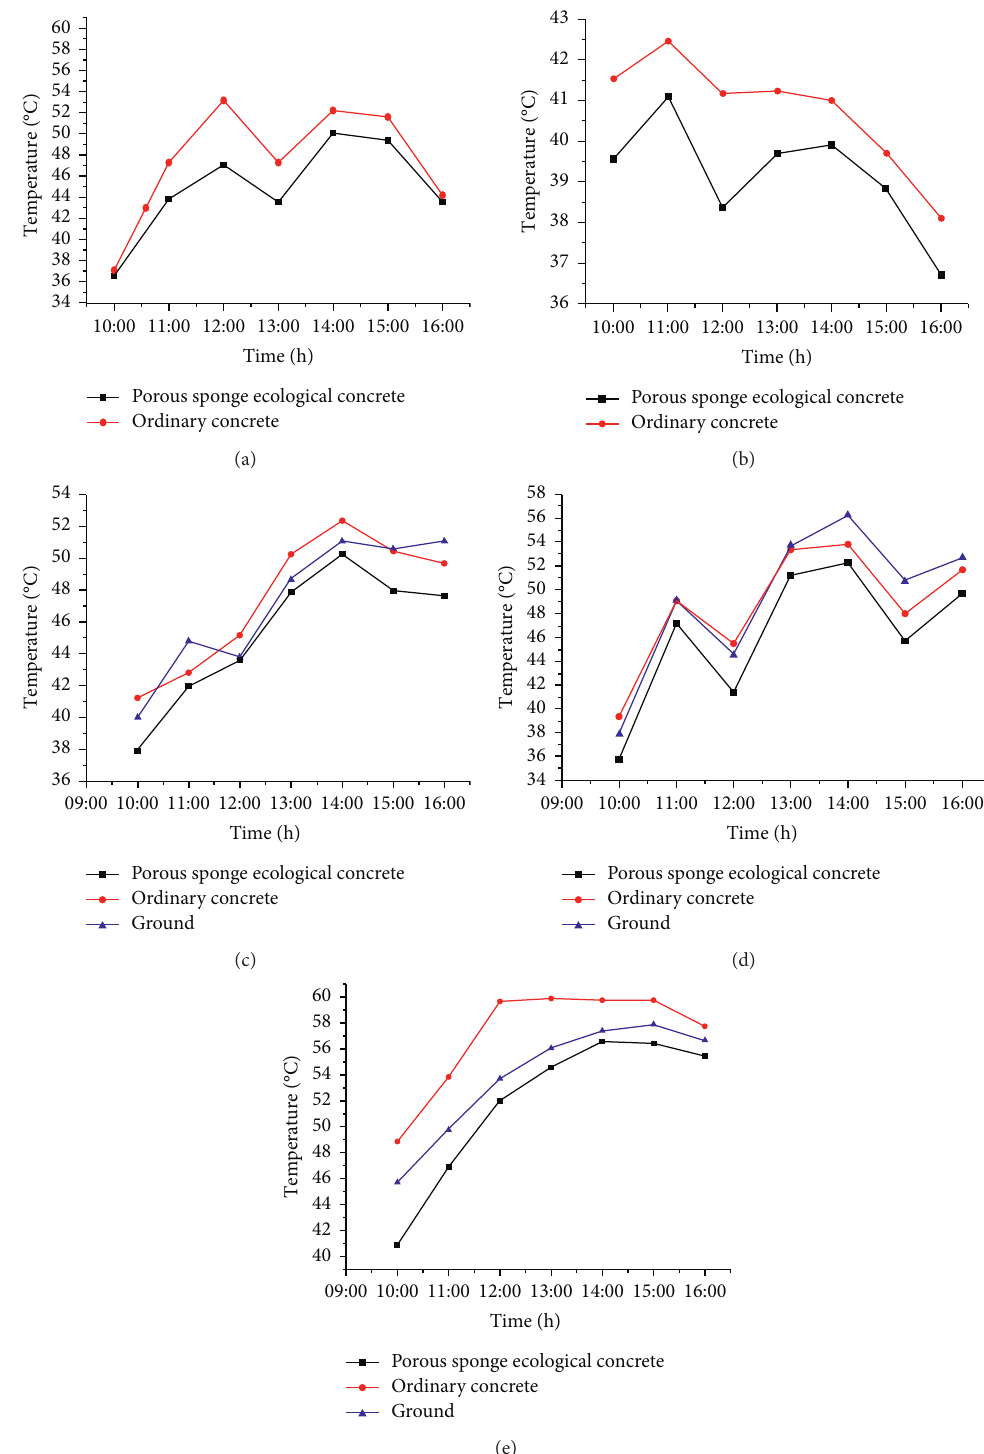
Figure 5: Temperature variation curve at different times on different days. (a) Temperature variation of porous sponge ecological concrete on the 1 st day. (b) Temperature variation of porous sponge ecological concrete on the 2 nd day. (c) Temperature variation of porous sponge ecological concrete on the 3 rd day. (d) Temperature variation of porous sponge ecological concrete on the 4 th day. (e) Temperature variation of porous sponge ecological concrete on the 5 th